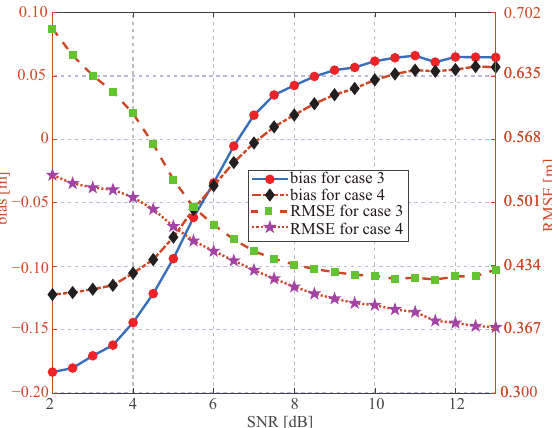
Figure 10. Biases and RMSEs between the retrieved SWH and ECMWF data at different SNR.